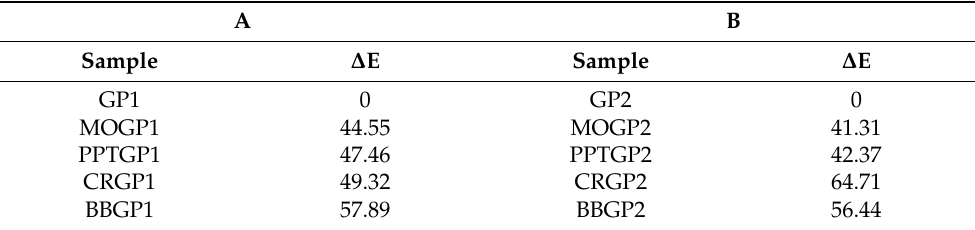
Table 2. ( A ) ∆ E of the samples (24 h at 25 ◦ C) compared with that of white sample GP1. ( B ) ∆ E of the samples (24 h at 40 ◦ C) compared with that of white sample